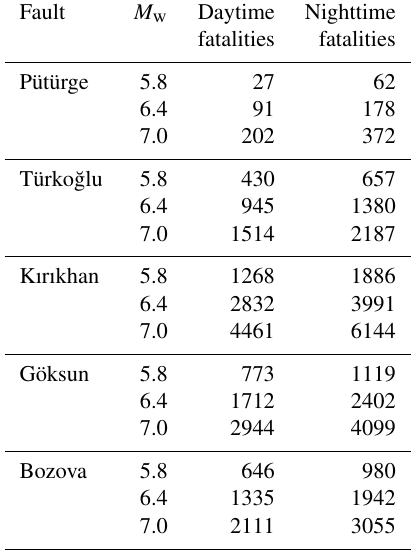
Table 4. Fatality estimates for non-refugee